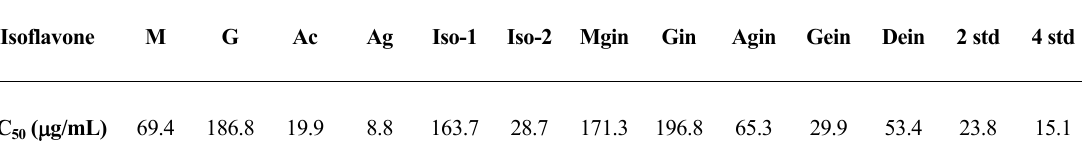
value of isoflavone fractions and extracts from Table 2. The IC 50 soybean cake as well as isoflavone